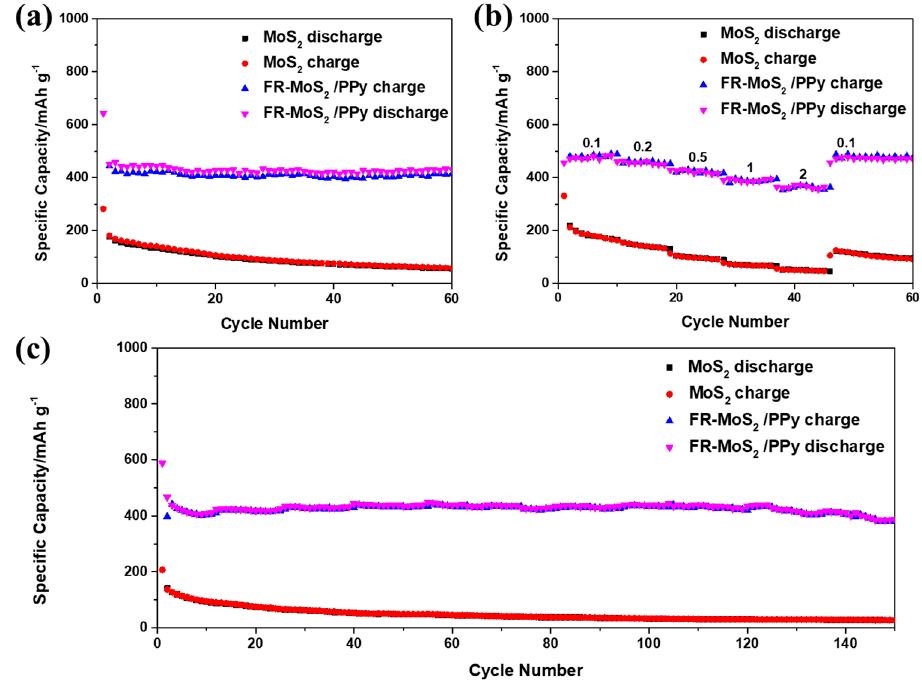
Figure 6. ( a ) Cycle performance under 100 mA g − 1 , ( b ) rate performance, and ( c ) cycle performance under 500 mA g − 1 of MoS 2 and FR-MoS 2 /PPy.